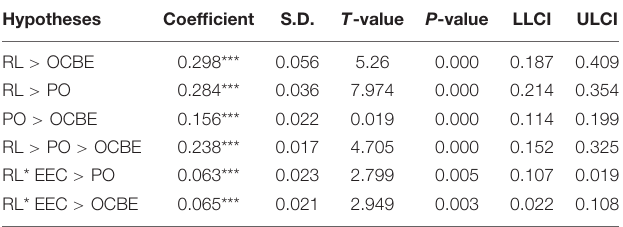
TABLE 8 | Results of the indirect conditional effect (moderation effect of EEC between RL and PO).